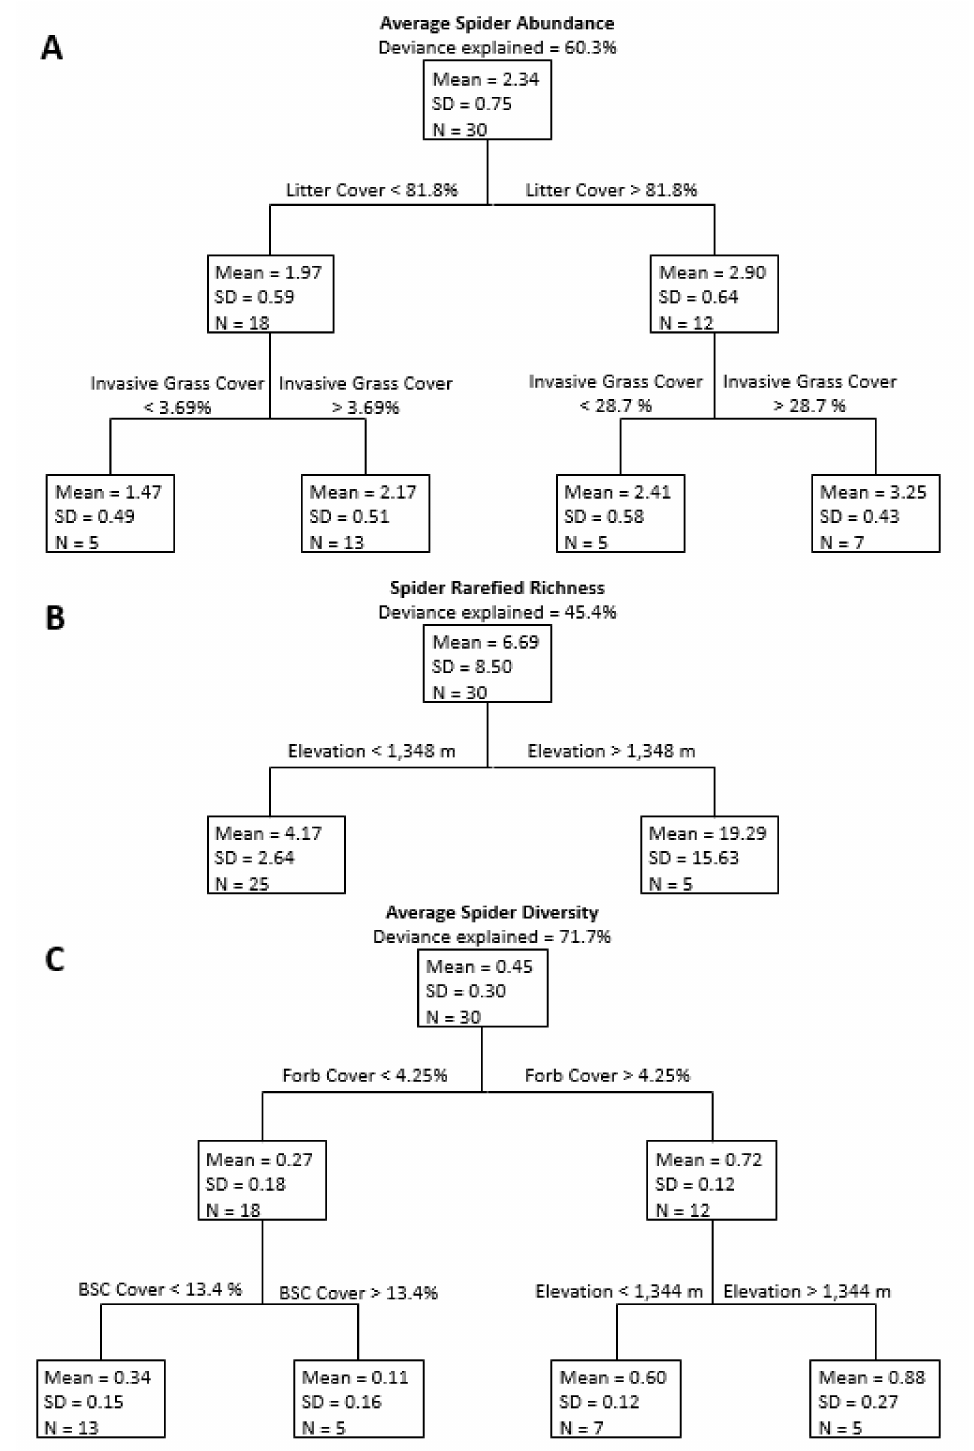
Figure 3. Regression trees for average spider abundance ( A ), rarefied richness ( B ), and diversity ( C ) using each study site. Deviance explained is the amount of variability explained by the full regression tree. Variables associated with each branch are above the horizontal lines above the nodes. Each node (box) of the trees includes mean response variables (spider abundance, rarefied richness, or spider diversity); standard deviation (SD); and sample size